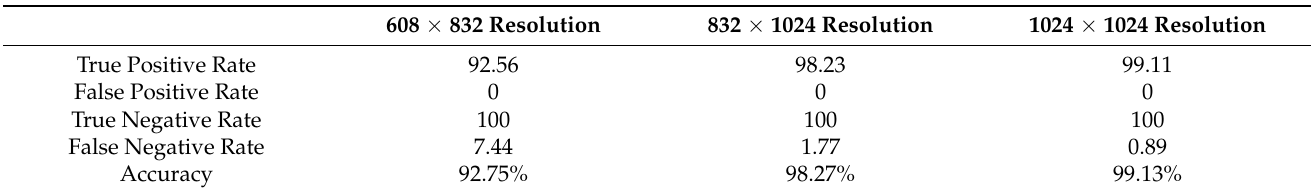
Table 2. Multiple resolution comparison of the muzzle detection accuracy and the true and false positive rates and negative rates during the YOLOv3 darknet-53 network test